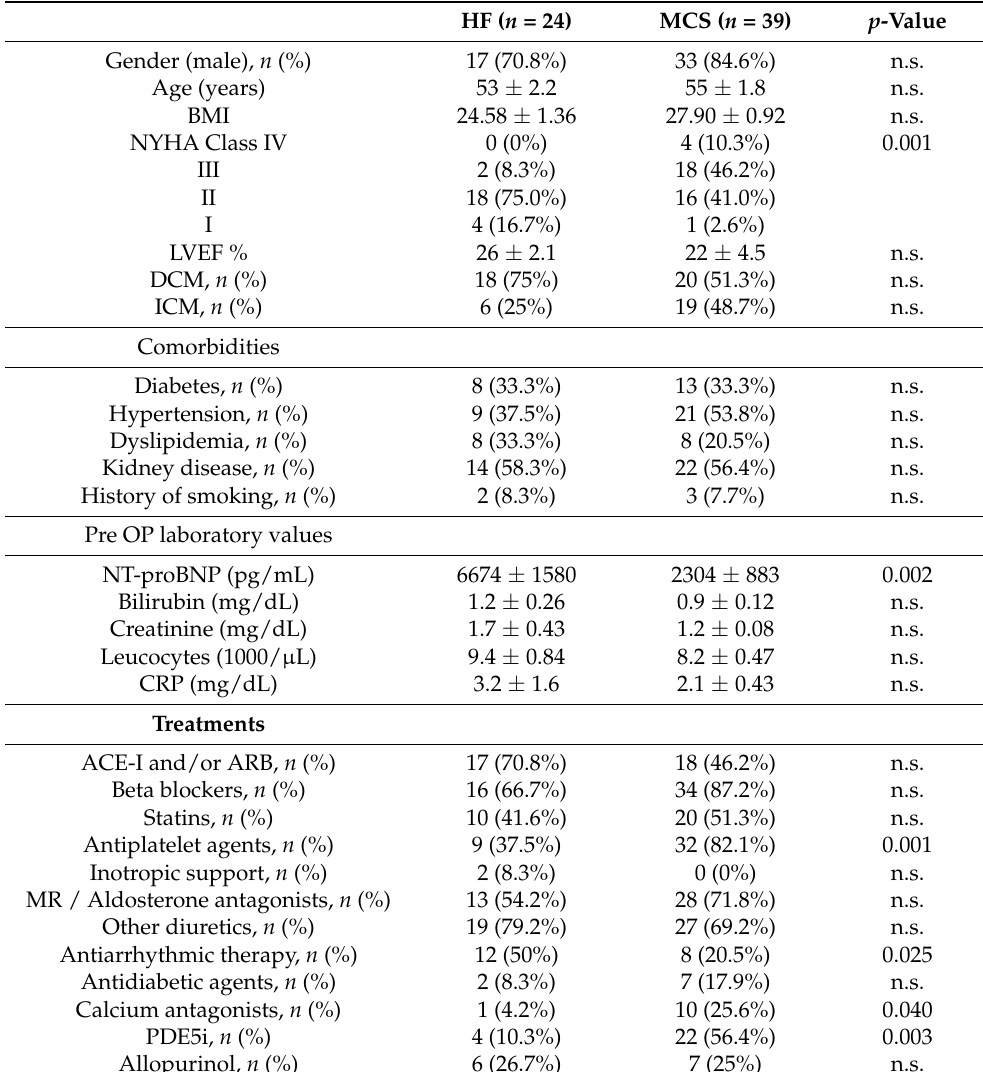
Table 1. Baseline